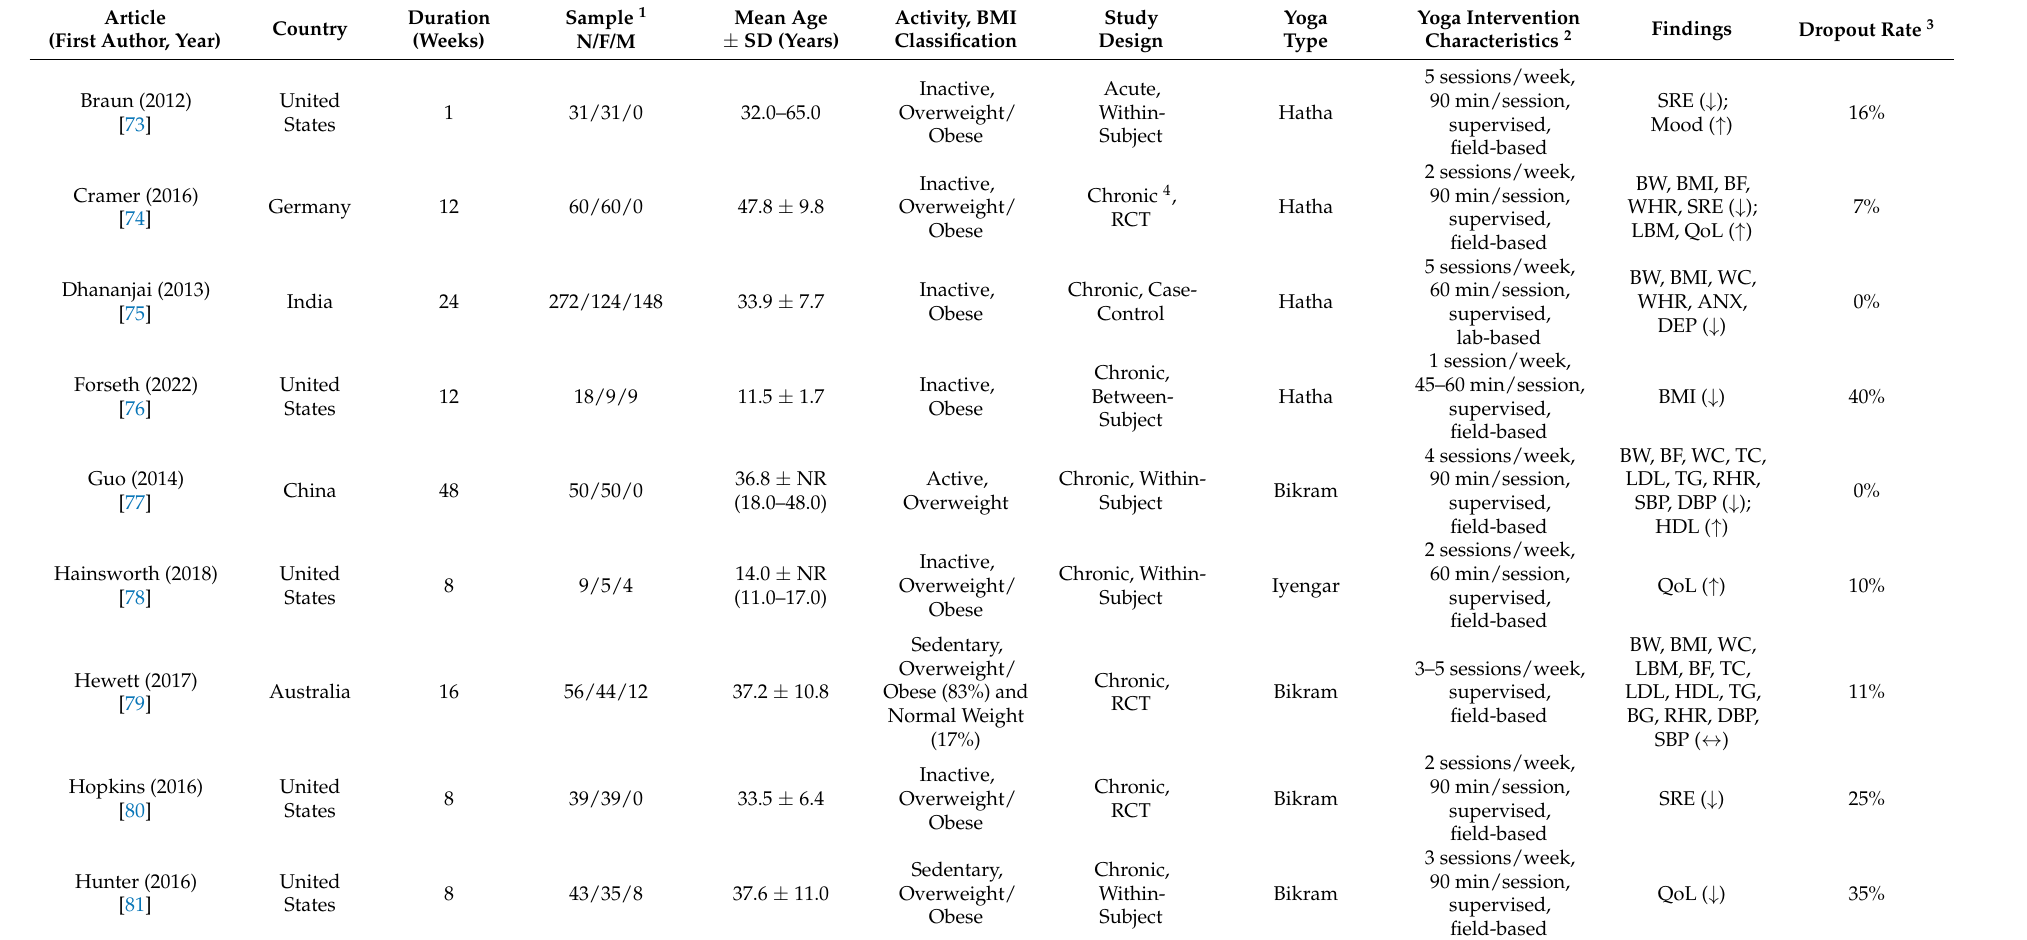
Table 1. Data extracted from each article included for